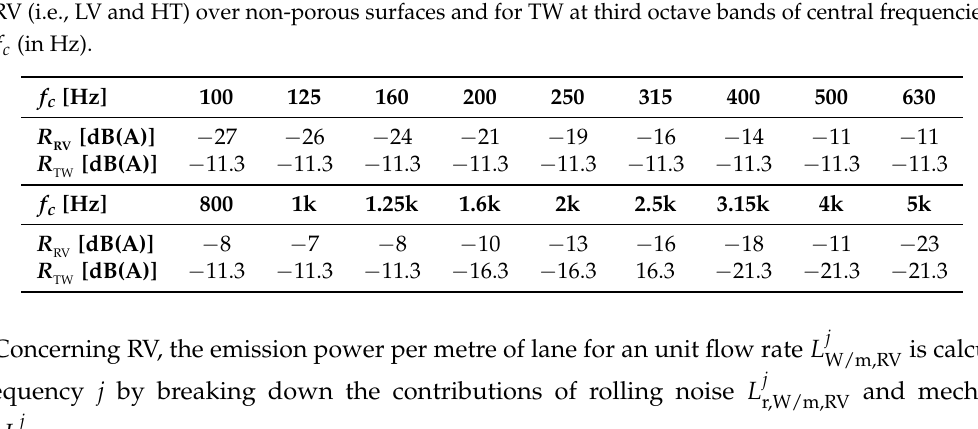
(in dB(A)) of an elementary point source for VC